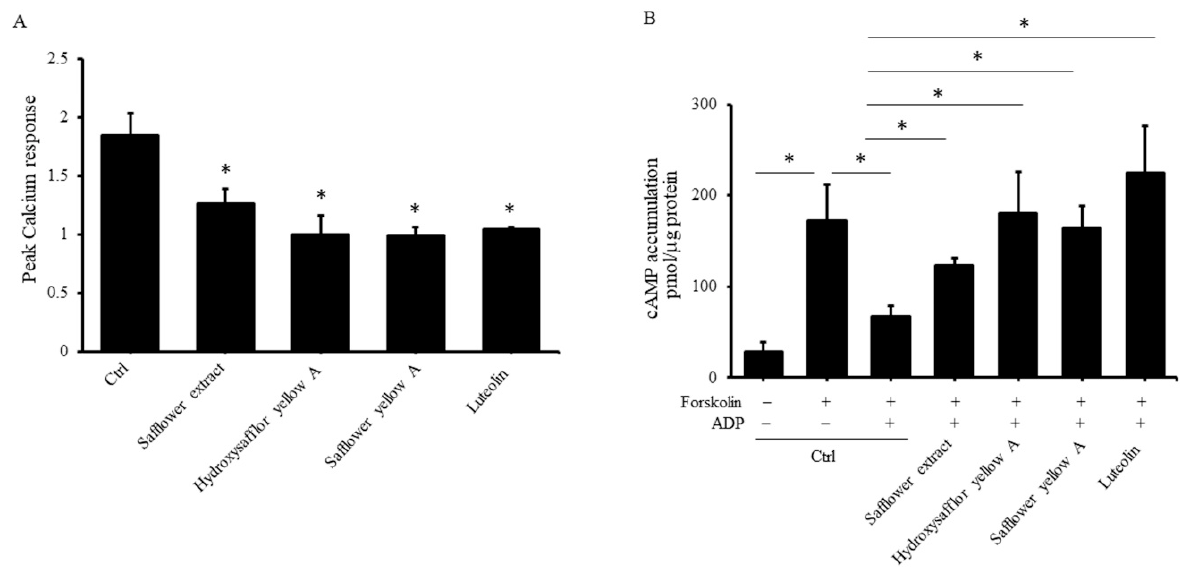
Figure 4. Effects of safflower extract on the production of calcium ions and cAMP in platelets. ( A ) PRP was treated with safflower extract or compounds found in safflower extract for 1 h and then reacted with Fura-2AM at 37 ◦ C. Isolated platelets were collected, and calcium responses induced by ADP were measured. ( B ) PRP was treated with safflower extract or compounds found in safflower extract for 1 h. The purified platelets were collected and reacted with 10 µ M forskolin and 10 µ M ADP at 37 ◦ C. Cell lysates were prepared, and the cAMP levels were measured by enzyme immunoassay. * p < 0.05 between two groups.